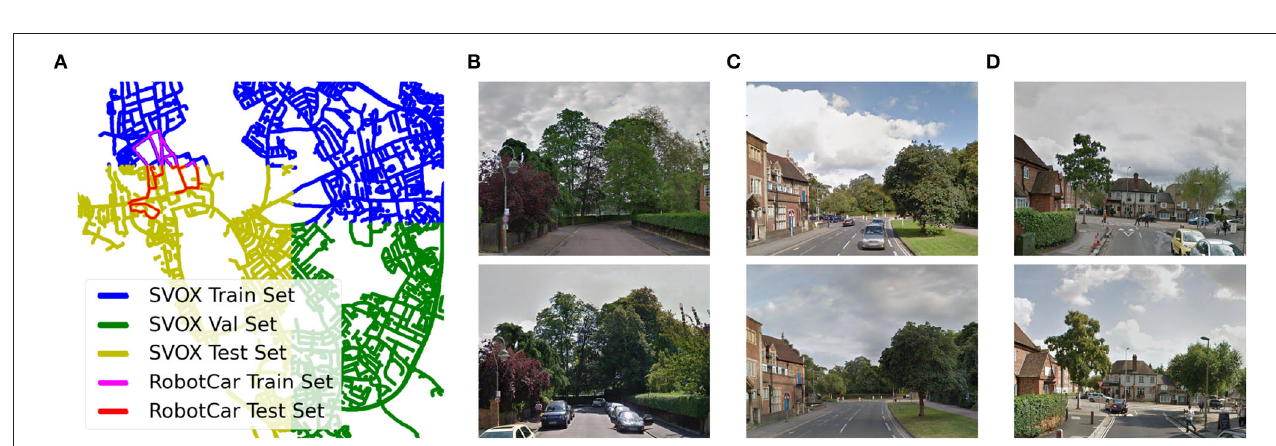
FIGURE 1 | The appearance of a place viewed from the same perspective can drastically change in different environmental conditions. (A) Image from the city of Oxford taken from Google StreetView. (B–F) Images taken from of the Oxford RobotCar dataset (Maddern et al., 2017), that show the same place as in A but in different conditions, i.e., snow, rain, sun, night and overcast, respectively.